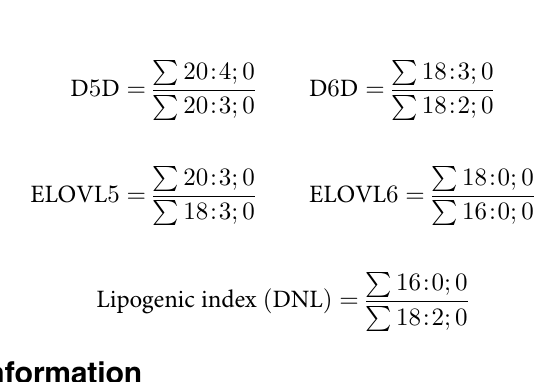
S1 Text. Further discussion on lipid correlations with BFP. BFP, body fat percentage. (PDF) S1 Fig. Lipid species coefficients of variation. (A) Coefficient of variation ( CV ¼ SD i ) for all i mean i lipid subspecies, clustered and colored by lipid class. The number of measurements per species is indicated as point size ( n ). (B) Coefficient of variation for all lipid species within each sex individually are shown on the x-axis. On the y-axis Spearman correlations ( ρ ) to BFP are dis- played as in Fig 4 in the main article. Coefficient of variation data is provided in the S3 Table. BFP, body fat percentage. S2 Fig. FINRISK dependent variables. Characteristics of FINRISK variables: Distribution of (A) BMI, (B) WHR, (C) BFPs (Fat mass [%]) in the data set. (A–C) The distribution’s mean, stan- dard deviation, and number of subjects ( n ), excluding missing values, are shown in the upper left corner. Vertical dashed lines indicate the 5th and 95th percentile. Relationship of BMI to (D) WHR and (E) Fat mass according to subject sex. Lines are based on local polynomial regression fitting (loess). BFP, body fat percentage; BMI, body mass index; WHR, waist-hip ratio. (PDF) S3 Fig. Sex differences of lipid species. Volcano plot of sex differences between 571 female and 490 male subjects. P -values of the Mann–Whitney U test are displayed on the y-axis, fold changes of means are shown on the x-axis, which is calculated as female (f) divided by male (m) lipid levels ( FC ¼ lipid ð f Þ ). Labels at the top also indicate the direction of the fold change. lipid ð m Þ Points with outlines show significance < 0.05 after Benjamini-Hochberg correction for multi- ple testing. Some of most significant SM species containing 4E,14Z-sphingadiene are labeled. All data displayed is provided in S4 Table. SM, sphingomyelin. S4 Fig. Lasso models. MAE for BFP Lasso models with different number of predictors. The lowest MAE of 3.61 ± 0.33 was achieved by a fraction of 0.24, which used 58 lipid subspecies, whereas a model at 1 standard error distance with a MAE of 3.65 ± 0.33 used a fraction of 0.2 and 45 lipid predictors. The data are shown in S6 Table. BFP, body fat percentage; MAE, mean absolute error. S5 Fig. Lasso model predictors. β -coefficients of the predictors of the best Lasso model predict- ing BFP with the lowest MAE and the model at 1 standard error distance (as in S4 Fig) are dis- played. The data are shown in S6 Table. BFP, body fat percentage; MAE, mean absolute error.